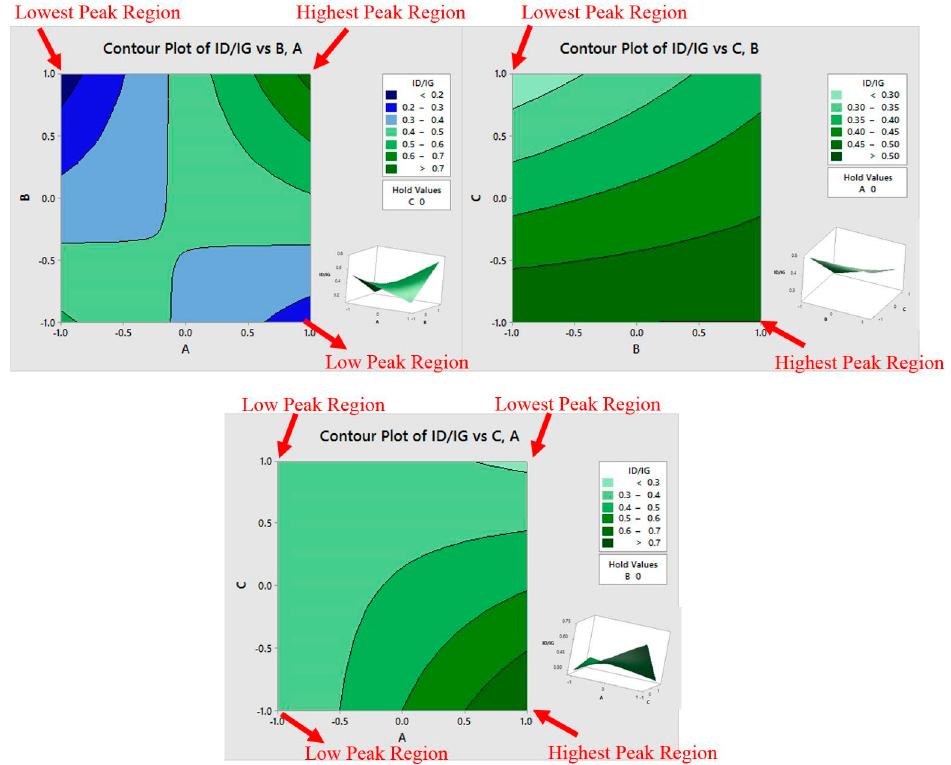
Figure 7. Contour plots for Response I with respect to the factors “A”, “B” and “C”; insets show the surface plots. High levels of the factor “A” and the factor “C” and a low level of the factor “B” indicate a low value of the I D /I G peak intensity ratio.